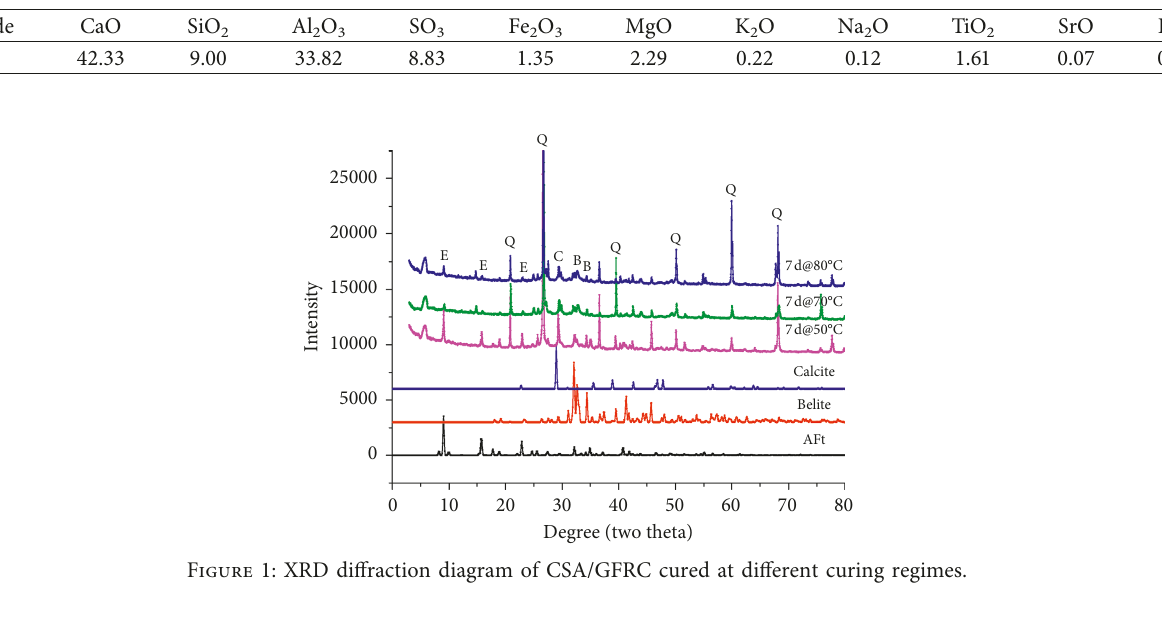
Table 1: Chemical composition of the CSA cement (wt.%).